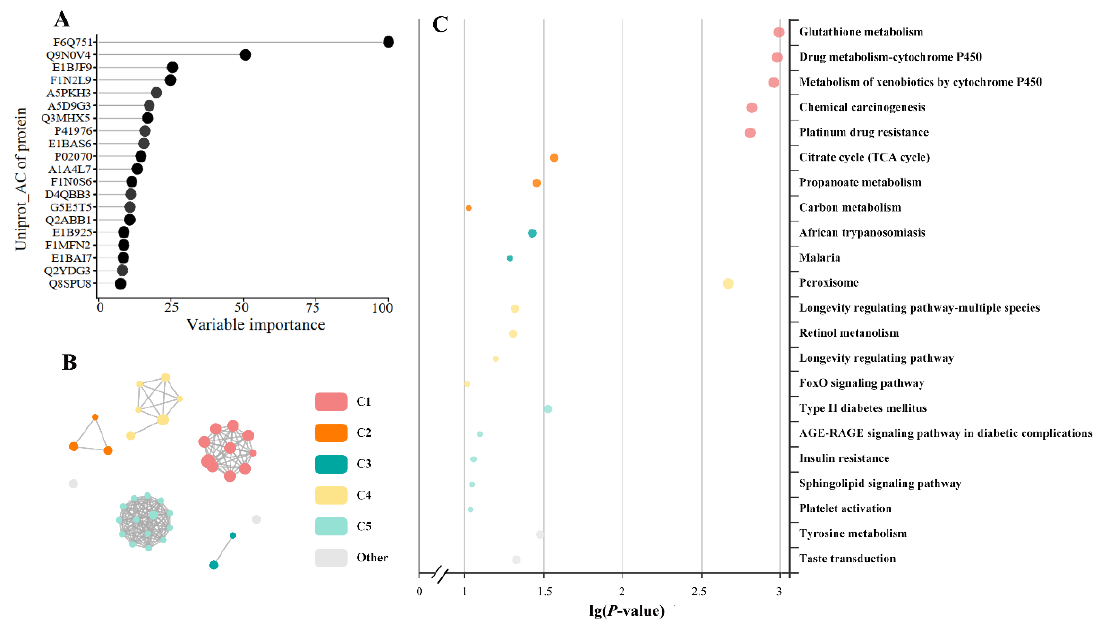
Figure 4. Liver protein profiles. ( A ) Top 20 most important proteins as found by a partial least squares regression associated with oxidative stress, fatty acid metabolism, and the concentration of NEFA in plasma, and of MDA, GPx, and triacylglycerol in the liver. ( B ) Network of enriched KEGG pathways. The nodes represent KEGG pathways, and the node colors represent different clusters; the node size represents 6 levels of enriched p -value (from smallest to largest): [0.05, 1], [0.01, 0.05], [0.001, 0.0), [0.0001, 0.00), [10 − 10 , 0.0001), (0, 10 − 10 ]; and correlated pathways are linked with lines. The pathways in each of the clusters are listed in Table S5. ( C ) Bubbles of KEGG pathways enriched in the RPG treatment. The color and size of the bubbles are the same as the color and size in the circular network. If there are more than 5 enriched KEGG pathways per cluster, the top 5 with the highest enrichment ratio are displayed.